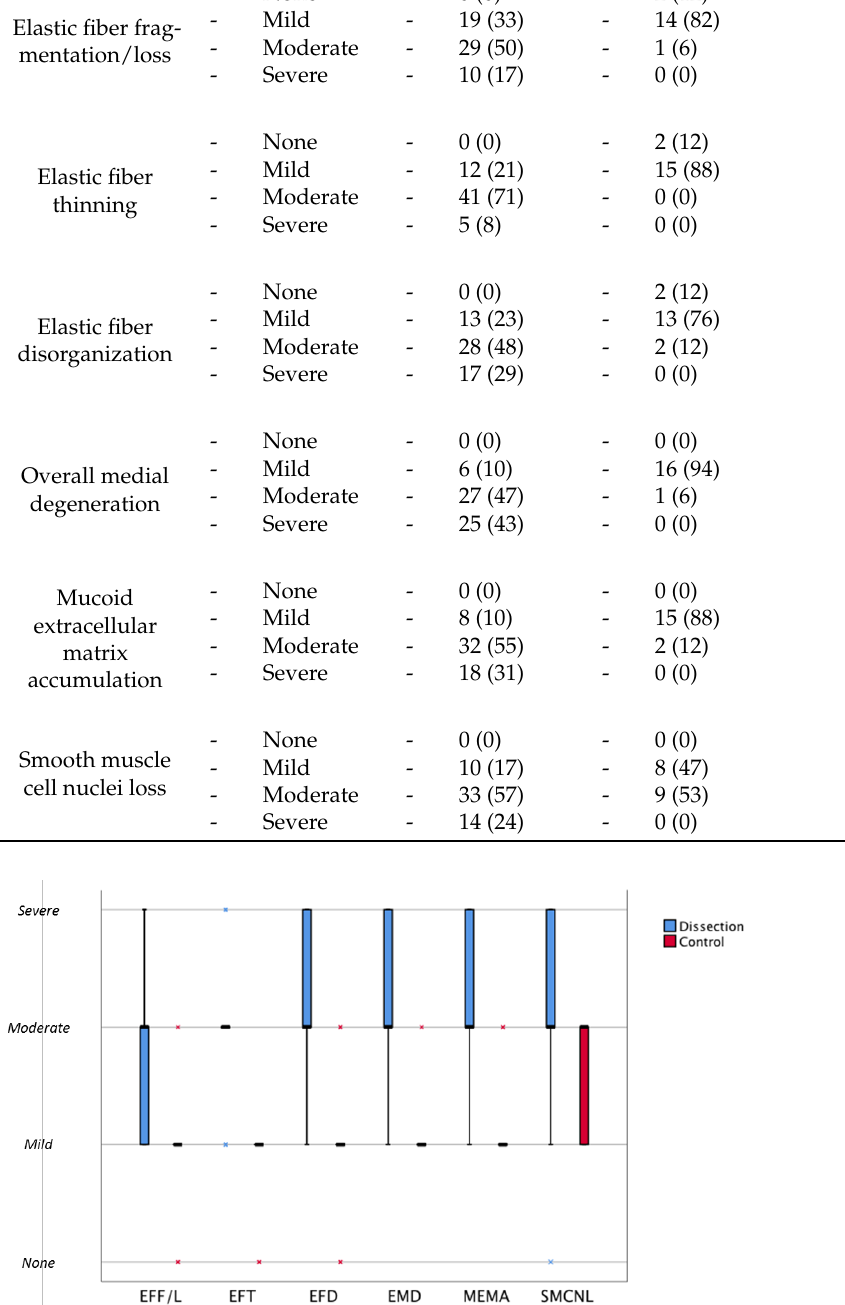
Figure 3. Graph of median morphology scores comparing the dissection and control group. Boxplot of median morphological scores comparing the dissection and control group. Boxes represent median morphological score (bold horizontal lines) and interquartile ranges (75%; 25%). Extremes are presented as asterisks. Blue corresponds to the dissection group and red to the control group. EFF/L: elastic fiber fragmentation/loss; EFT: elastic fiber thinning; EFD: elastic fiber degeneration; OMD: overall medial degeneration; MEMA: mucoid extracellular matrix accumulation; SMCNL: smooth muscle cell nuclei loss.